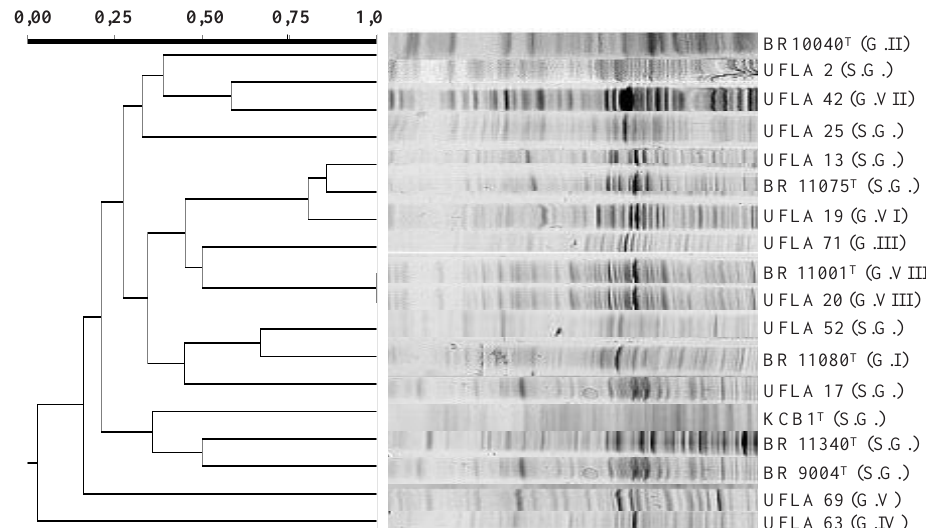
Figura 3. Dendrograma de similaridade construído com base nos perfis protéicos dos representantes dos isolados de bactérias diazotróficas e das estirpes tipo. SG: isolado sem grupo. G: isolado